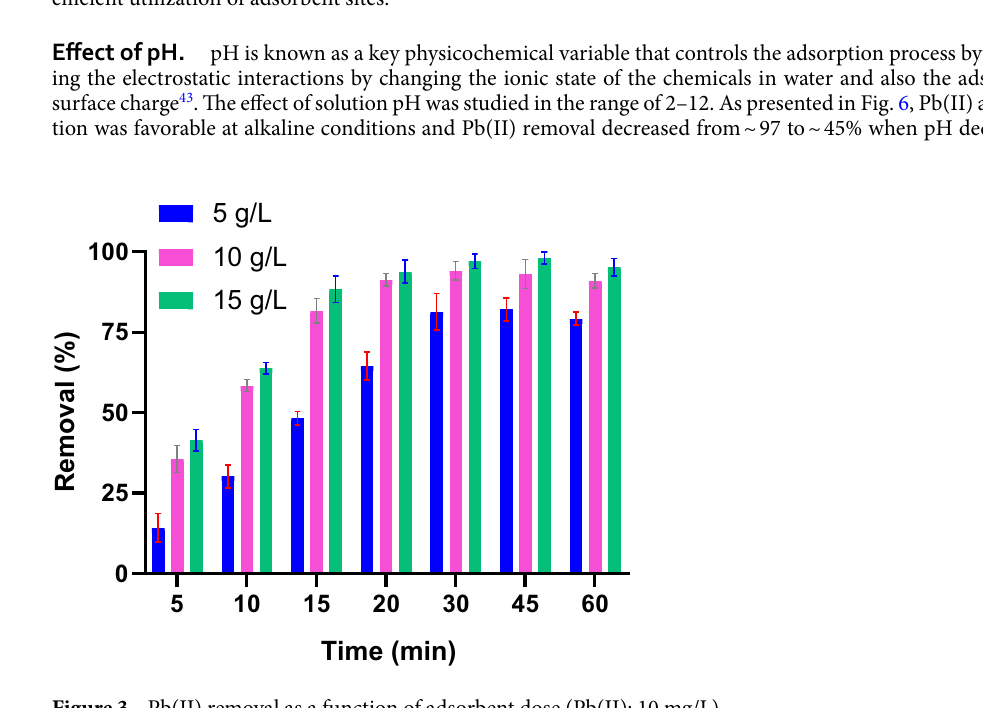
Figure 3. Pb(II) removal as a function of adsorbent dose (Pb(II): 10